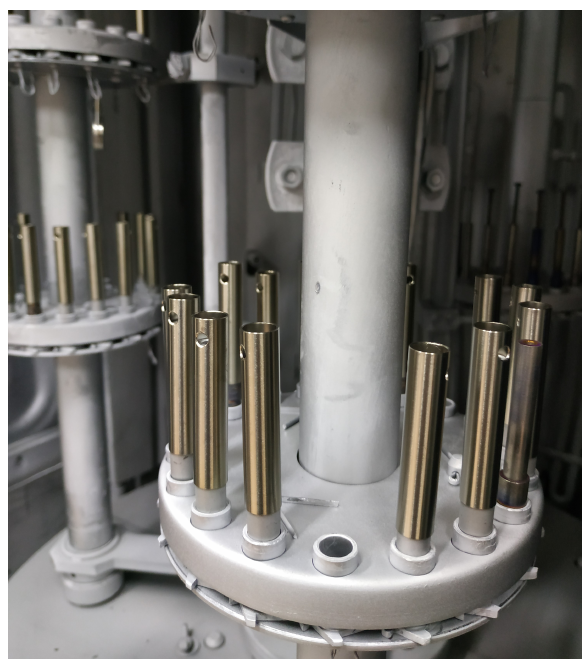
Figure 1. The chamber of Hauzer Flexicoat 850 system.